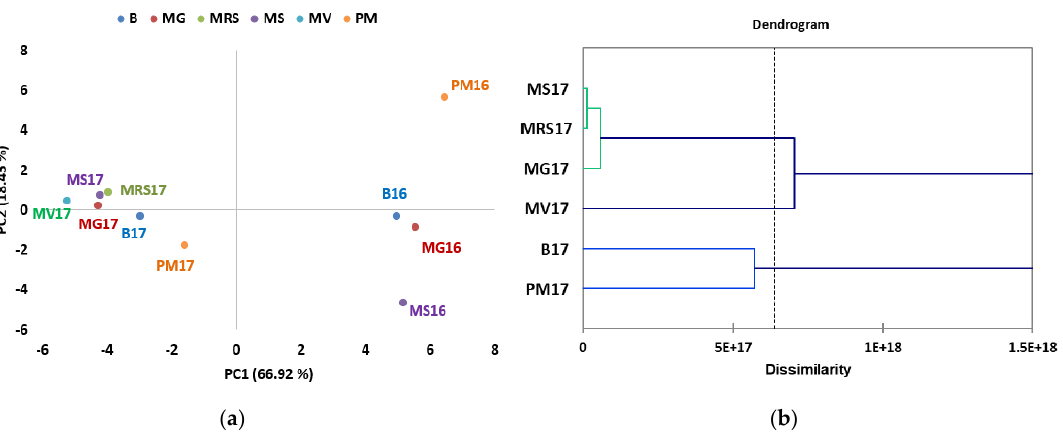
Figure 6. ( a ) PCA based on fatty acids and some derivatives UHPLC/MS-MS fingerprints of the fruits of different chestnut cultivars harvested in 2016 and 2017 and ( b ) Dendrogram of the fruits of different chestnut cultivars harvested in 2017 (‘Précoce Migoule’—PM, ‘Bournette’—B, ‘Marsol’—MS, ‘Marissard’—MRS, ‘Marigoule’—MG and ‘Maraval’—MV) . 3.4. Sugars Profile of Different Chestnut Cultivars Harvested in Two Years Carbohydrates are relevant components in chestnuts, with sucrose being an im- portant parameter in assessing the quality of the fruit. Together with sucrose, glucose and fructose are present in significant amounts in chestnuts, the profile of free sugars contrib- uting to the identification of chestnut cultivars. Sugar profile can be influenced by several conditions, such as cultivars, genotypes, environmental factors (climatic conditions, soil characteristics) technical and cultural practices, and harvest time [10]. Large and significant differences ( p < 0.0001) in sugar content values were detected among cultivars and harvest years (Table 5). The obtained data were expressed as mean